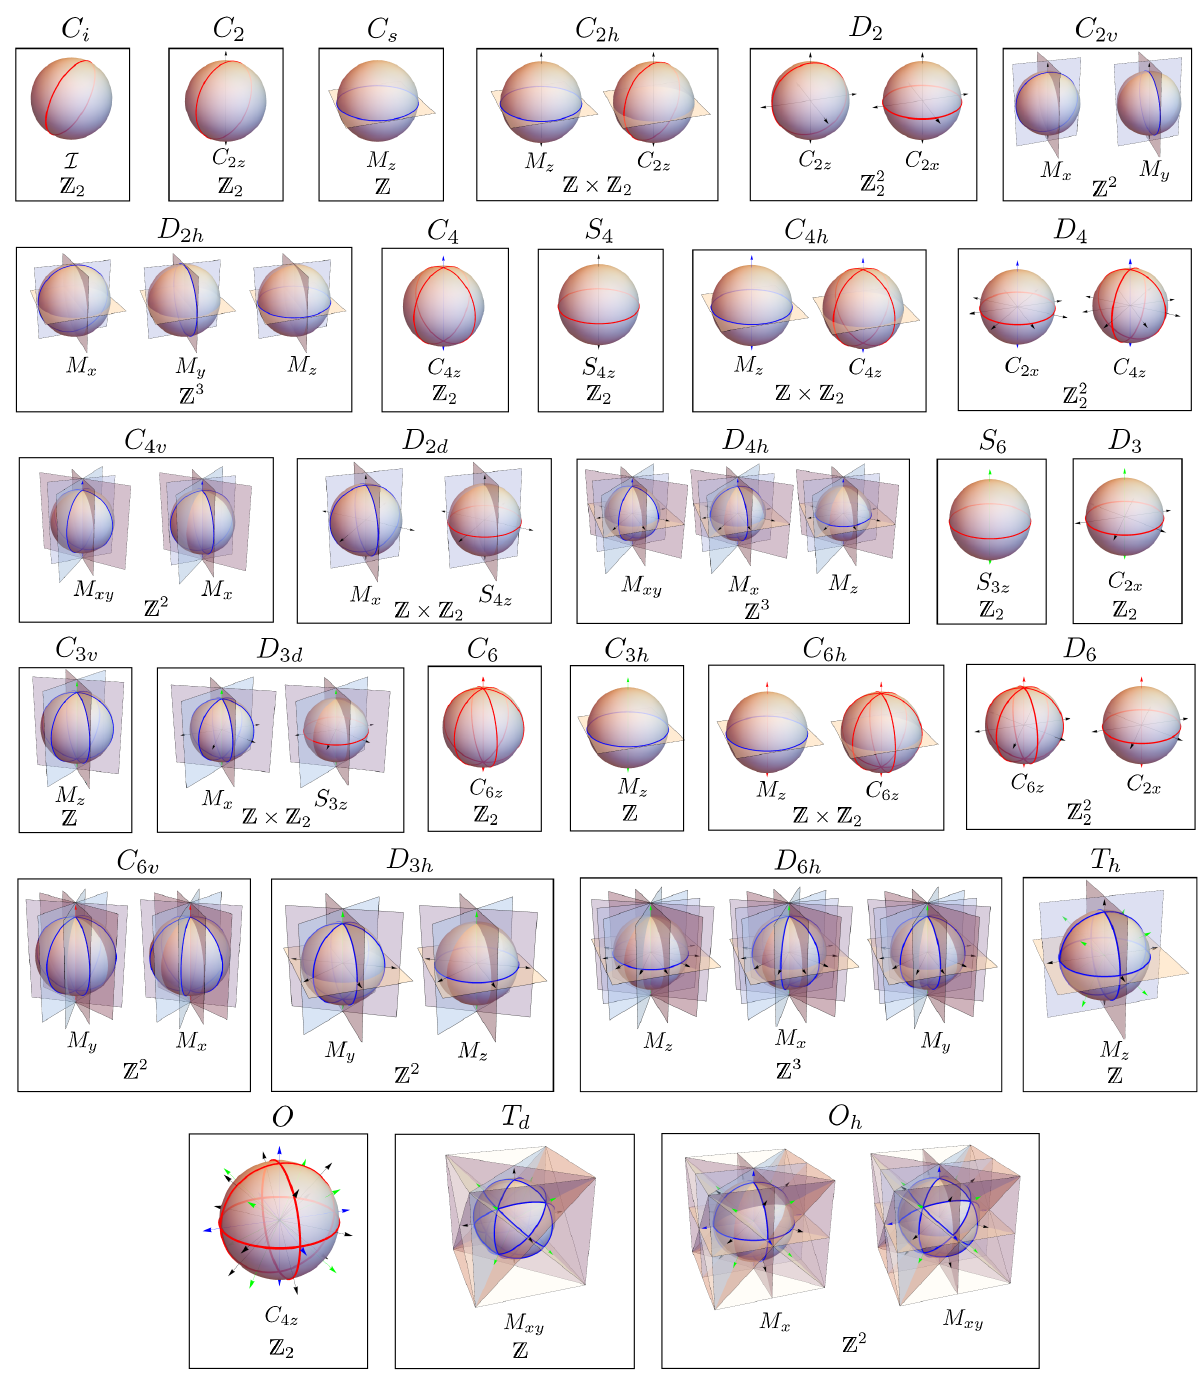
FIG. 4. Graphical illustration of the surface states of the hinge phases, which generate all sTCIs for the 32 crystallographic point groups, on a sphere. For each state, we show the operators that need to be taken in the “ − ” representation as well as the resulting classification. Red circles indicate Z 2 modes that would be gapped-out if two copies of the system were stacked together, whereas blue circles indicate Z modes protected by a mirror Chern number. Rotation axes are shown with black, blue, green, or red for twofold, fourfold, threefold, and sixfold rotations,